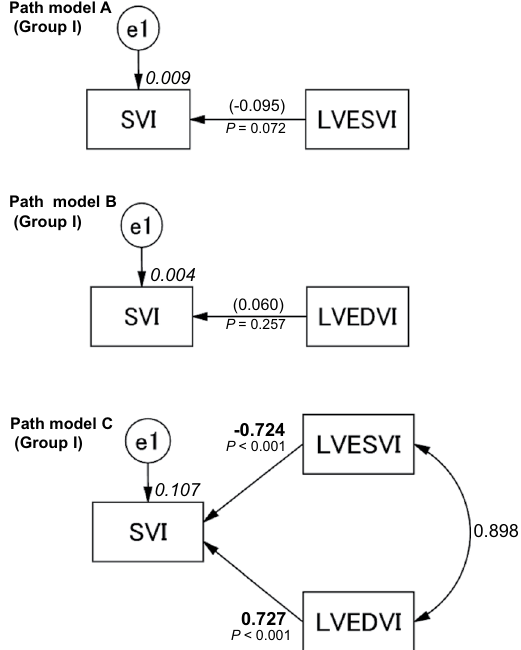
Figure 1. Path models A–C. The paths are displayed with coefficients that indicate the standardized coefficient of the regressing independent variable on the dependent variable of the relevant path (path model A, LVESVI to SVI; path model B, LVEDVI to SVI; path model C, LVESVI and/or LVEDVI to SVI) in Group I. These variables are standardized regression coefficients [direct effect; non-significant coefficients (inside round brackets)], squared multiple correlations [on the upper right side of rectangles (in italics)] and the correlations between each of the variables. Other variables that were included in the covariance structure analysis are presented in Supplemental Tables 2, 3 and 4. LVESVI, left ventricular end-systolic volume index; LVEDVI, left ventricular end-diastolic volume index; SVI, systolic volume index; and e, extraneous